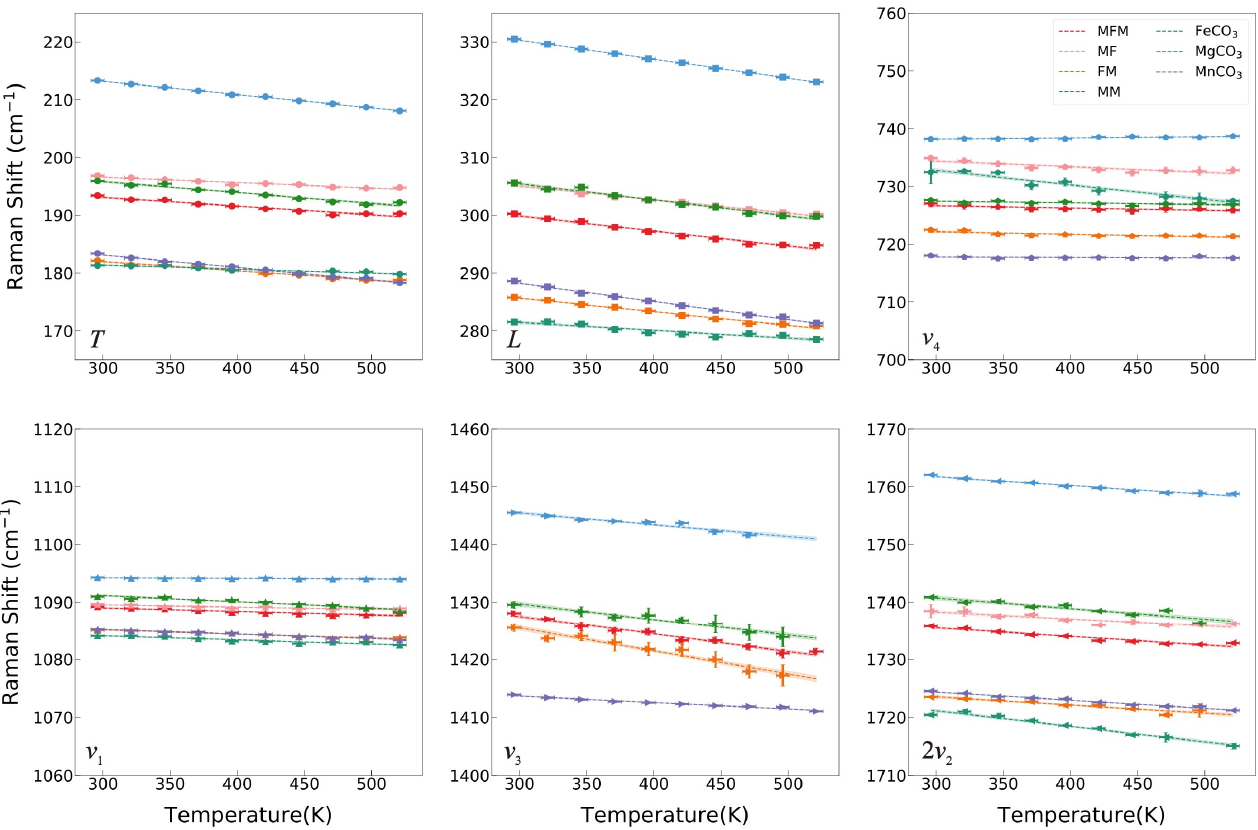
Figure 4. Raman shifts of MFM, MF, FM, MM, FeCO 3 , MgCO 3 , and MnCO 3 of each mode as a function of temperature can be modeled via a linear fit from 296 K to 521 K.